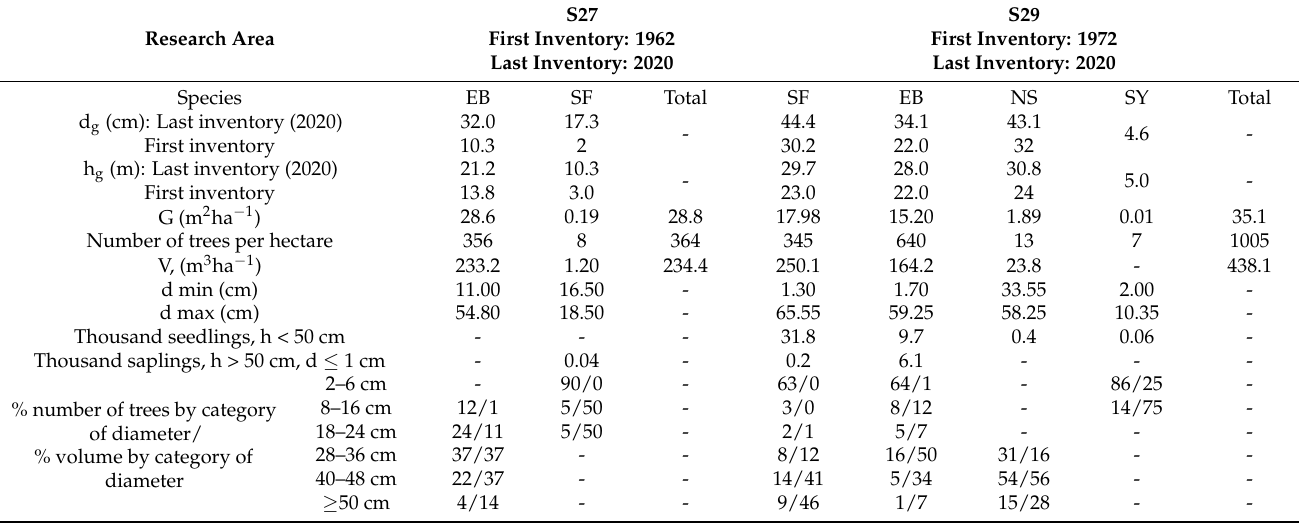
Table 4. Structural characteristics of two fully inventoried